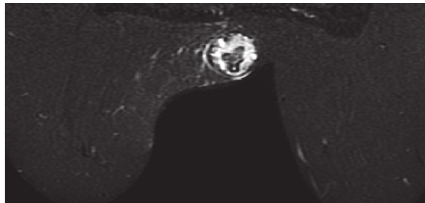
Figure 5: STIR sequence image demonstrates hypointense capsule and detached internal membrane with perilesional fluid accumula- tion eccentrically, revealing focal rupture.